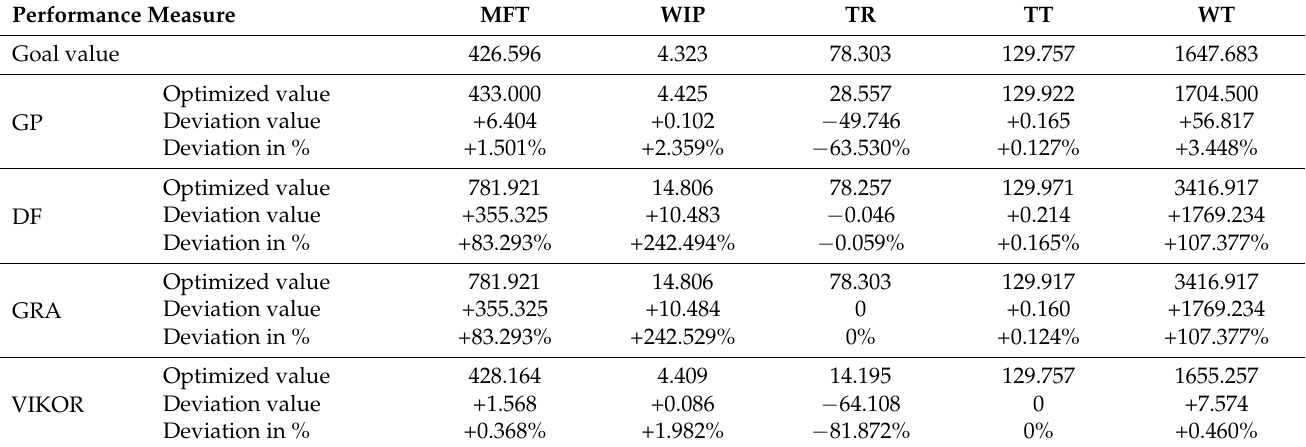
Table 9. MOSO results.